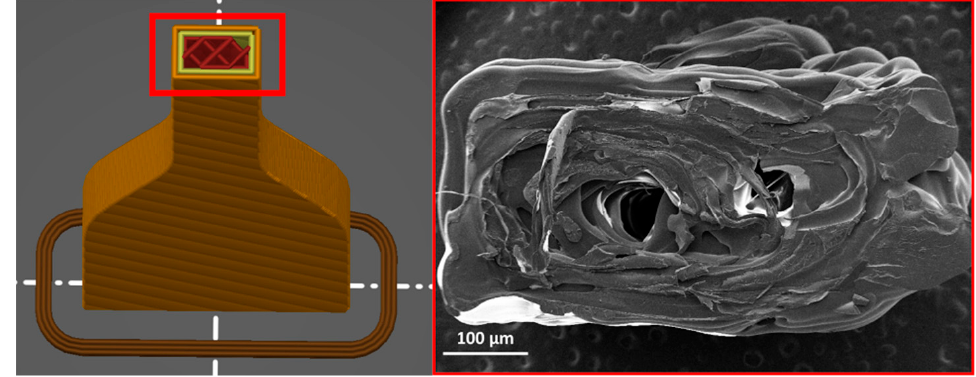
Figure 6. Interlayer adhesion of lignin incorporated of PLA-3%L at printing orientation of 90 ◦ . Table 3. Previous research on using lignin as a biofiller in FDM filament